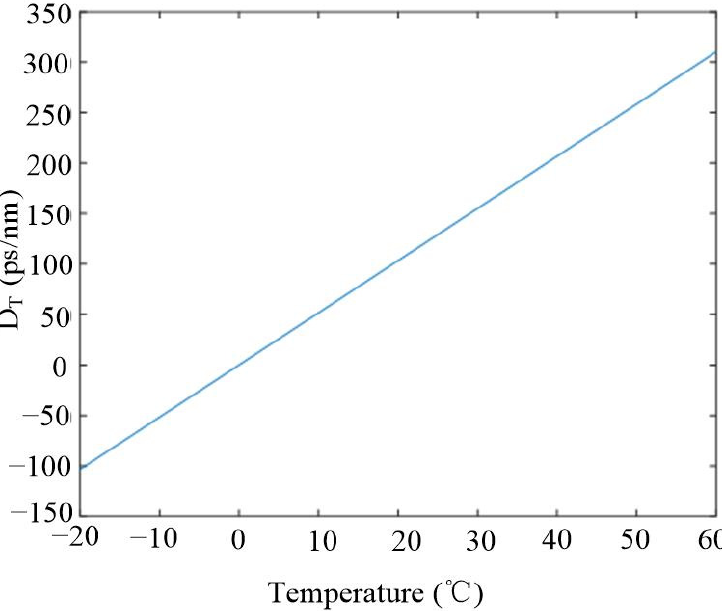
Figure 8. Dispersion parameters at different temperatures.